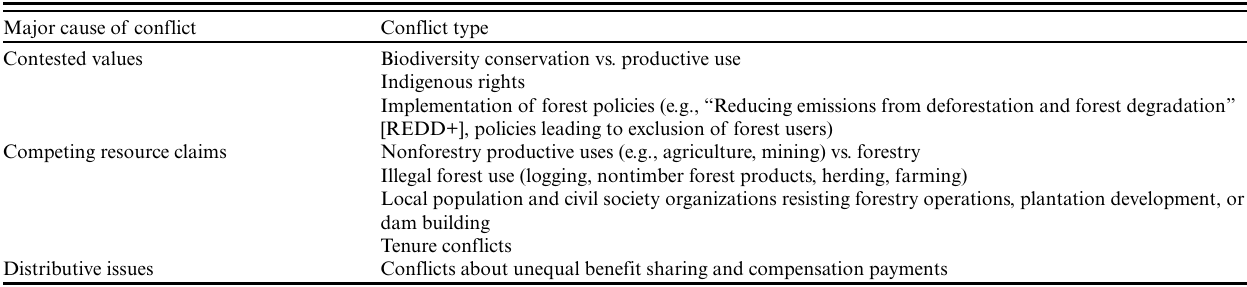
Table 1. Categorization of forest conflicts. Sources: Compiled from Yasmi et al. (2006), Vedeld et al. (2012), Eckerberg and Sandström (2013), Gritten et al. (2013), and Derkyi et al. (2014). Major cause of